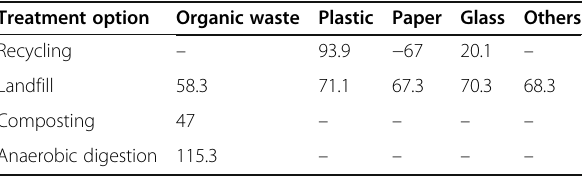
Table 8 The average economic cost of MSW treatment options